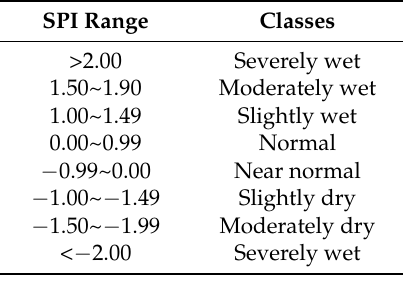
Table 2. Classification of SPI